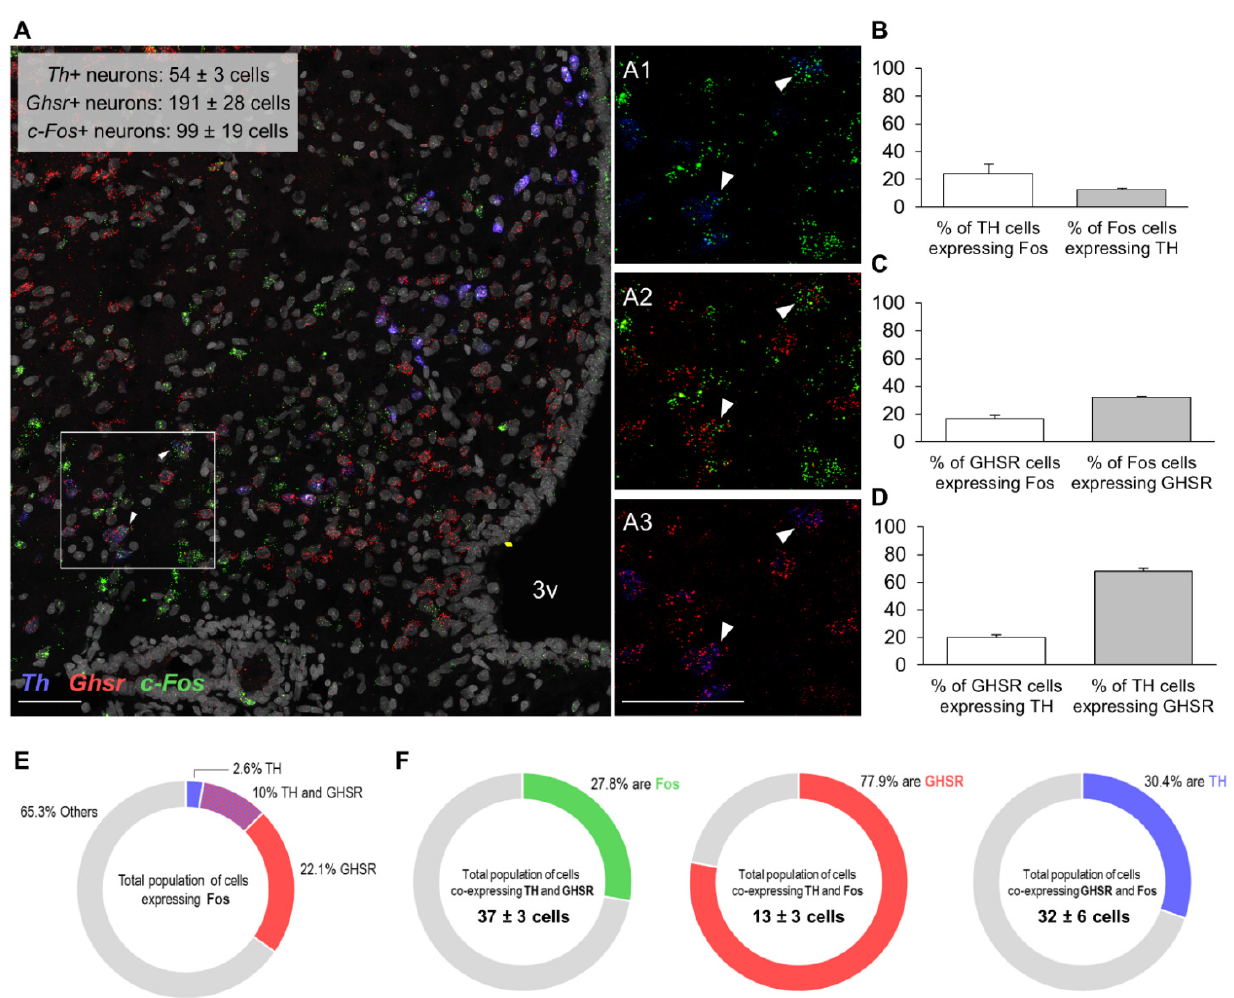
Figure 6. Colocalization of mRNAs for Fos protein, GHSR and TH in the Arc of non-food-deprived PB taste-familiar rats exposed to the olfactory PB cue. ( A ) Representative confocal images of triple RNAscope in situ hybridization for c-Fos (green), Ghsr (red) and Th (blue) in an Arc-containing section of a PB taste-familiar rat exposed to the olfactory PB cue. Area in the white rectangle is shown enlarged in the small panels on the right ( A1 – A3 ); colocalization of mRNAs for ( A1 ) Fos protein and TH; ( A2 ) Fos protein and GHSR; and ( A3 ) GHSR and TH. White arrows indicate triple positive cells. The graphs depict ( B ) % of TH cells that are Fos+, and the % of Fos cells that are TH+; ( C ) % of GHSR cells that are Fos+, and the % of Fos cells that are GHSR+; ( D ) % of GHSR cells that are TH+, and the % of TH cells that are GHSR+ (Data are represented as mean ± SEM). ( E ) Overview of the molecular identities of Fos+ cells; ( F ) triple colocalization data. 3v, third ventricle. Bregma: − 2.64 mm; Scale bar = 50 μ m (applies to all four images). Three hemisections per rat were quantified ( n = 3).